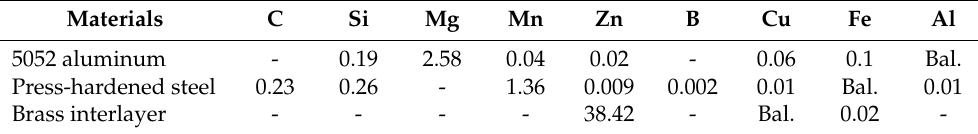
Figure 1. The microstructure of ( a ) press-hardened steel and ( b ) 5052 aluminum alloy. Table 1. Chemical composition of base materials analyzed by spark spectrometry (wt%).